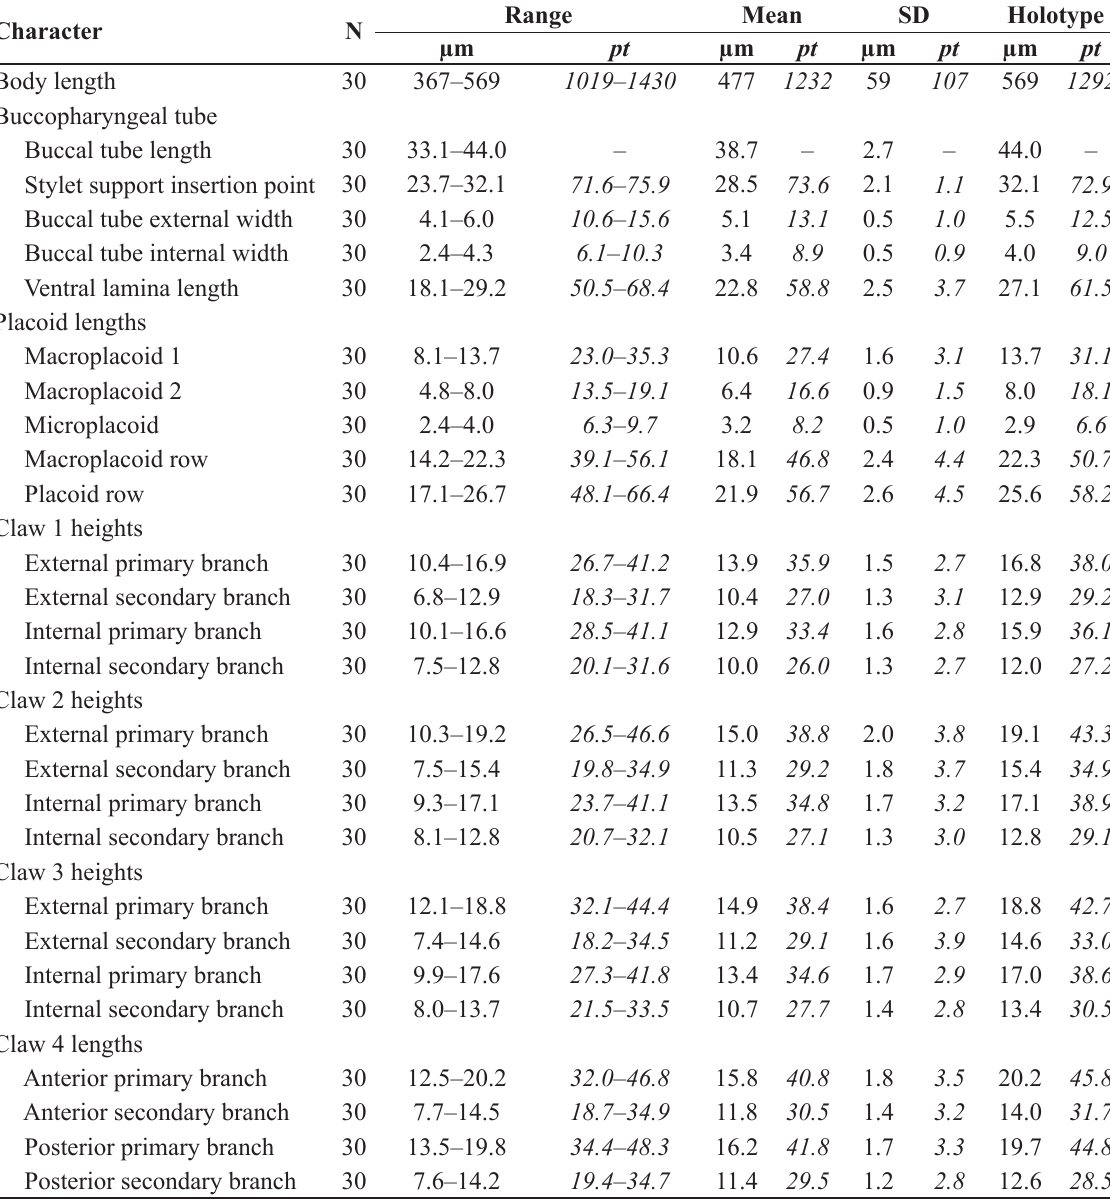
Table 4. Measurements (in μm) and pt values of selected morphological structures of the holotype and paratypes of Macrobiotus kamilae sp. nov. mounted in Hoyer’s medium (N = number of specimens / structures measured; Range = the smallest and the largest structure among all measured specimens; SD = standard